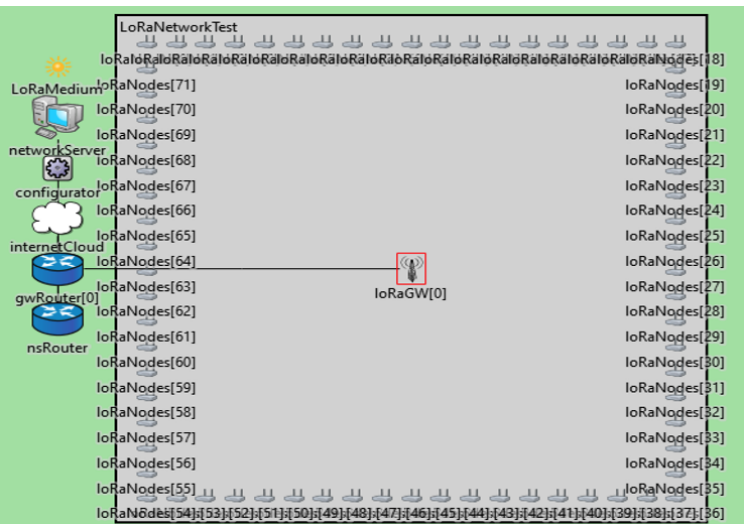
Figure 3. Layout of 72 nodes within a housing complex of 1 km² with a single gateway in